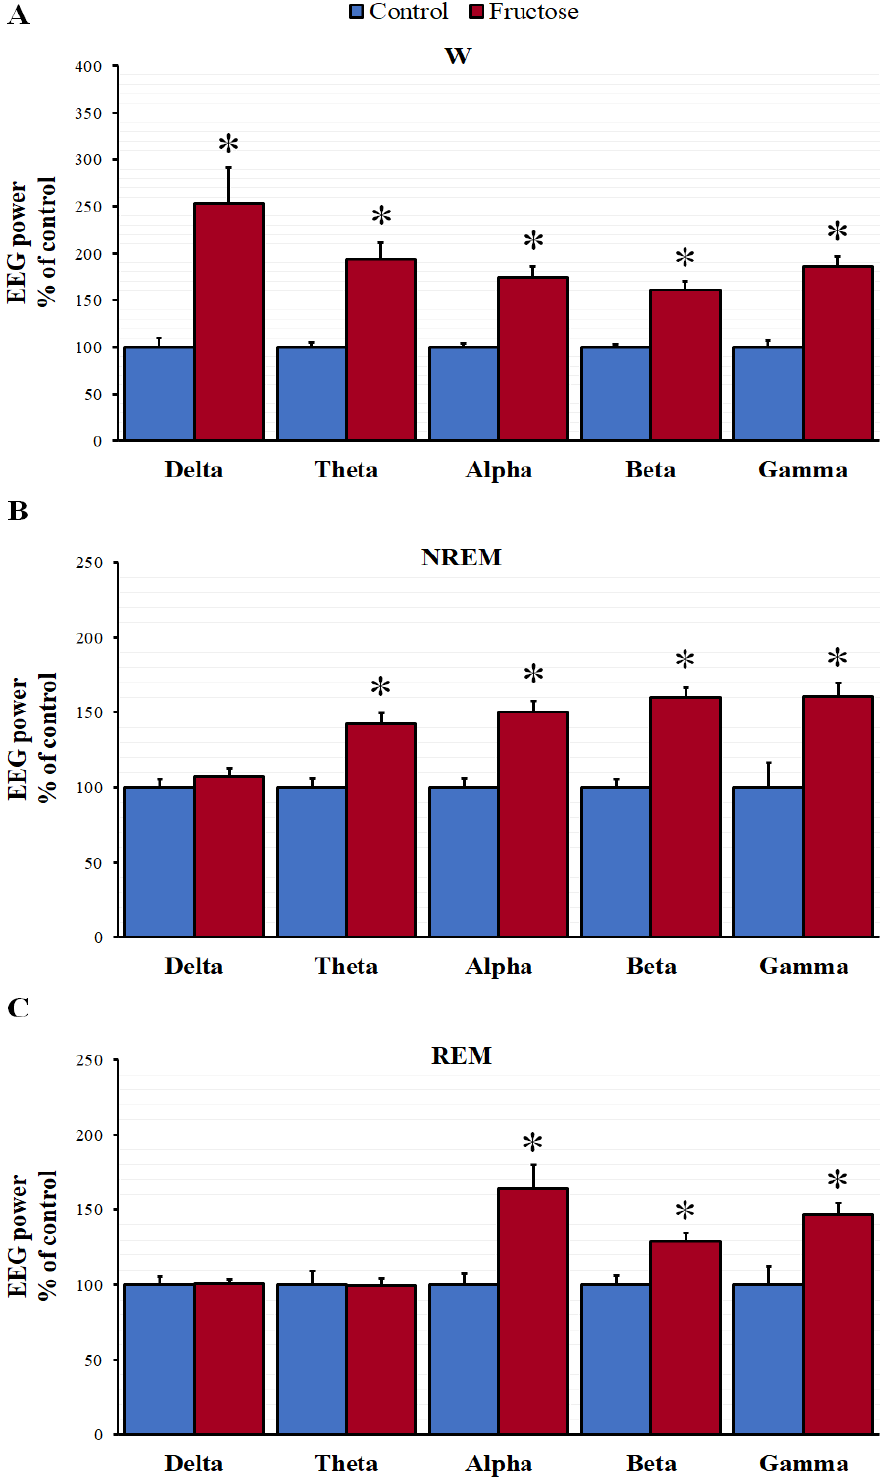
Figure 2. Spectral power of the electroencephalogram (EEG) in the different frequency bands (0.3–4 Hz delta; 4–8 Hz theta; 8–12 Hz alpha; 12–30 Hz beta and 30–70 Hz gamma) during W ( A ), NREM ( B ) and REM ( C ) episodes. Each bar represents the mean ± SEM of six rats per group. The results were compared statistically using a Mann–Whitney rank sum test (* p < 0.05 vs. control